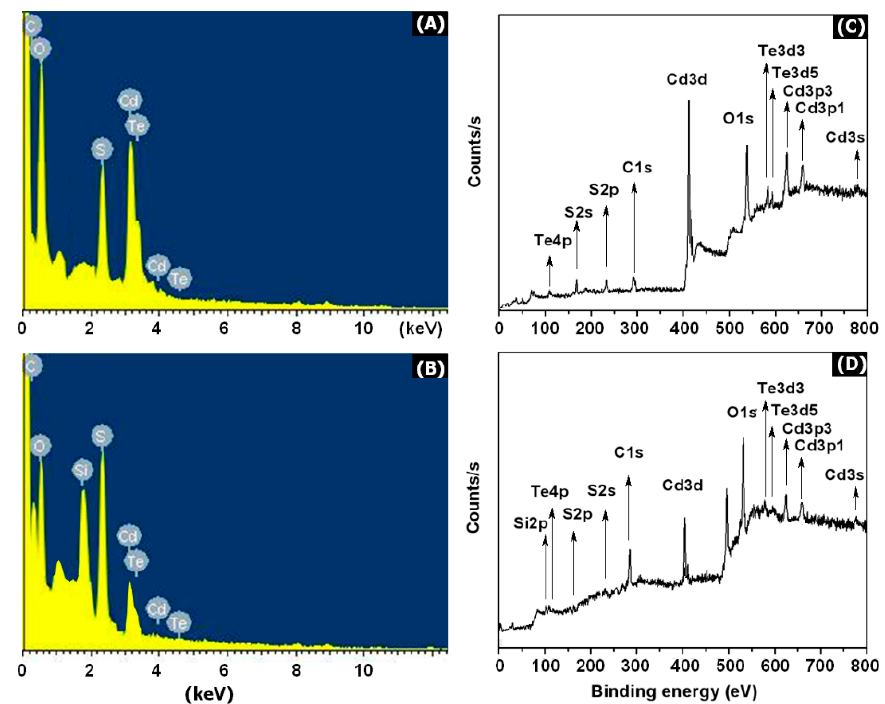
Figure 2. Energy-dispersive X-ray (EDX) spectra of ( A ) CdTe-OH and ( B ) CdTe-BTPT. X-ray photoelectron spectroscopy (XPS) spectra of wide-scan of ( C ) CdTe-OH, and ( D ) CdTe-BTPT.